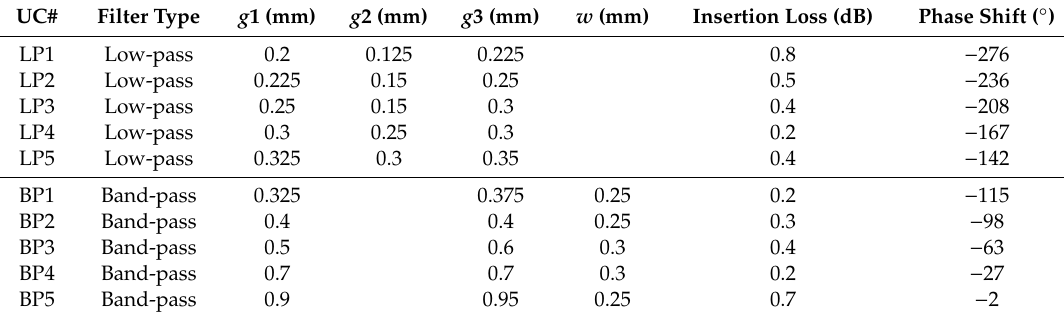
Table 1. Geometric parameters, insertion loss, and phase shift of low-pass and band-pass unit cells at 60 GHz with normal incidence.